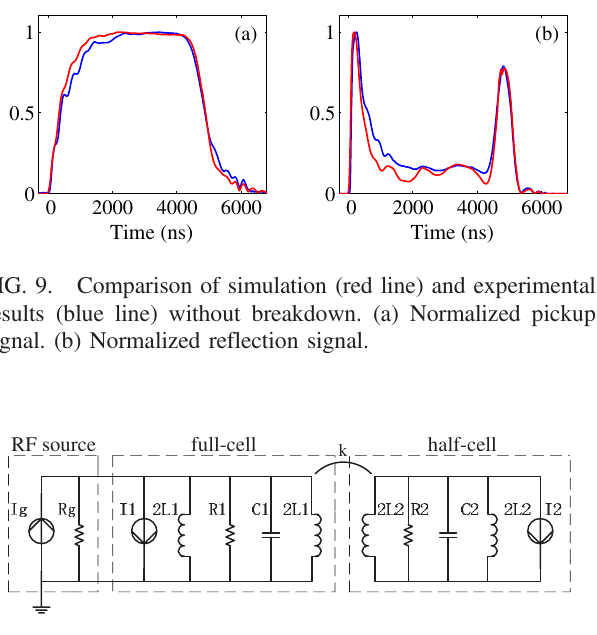
FIG. 10. Equivalent circuit model of the gun with two explosive emission current sources.